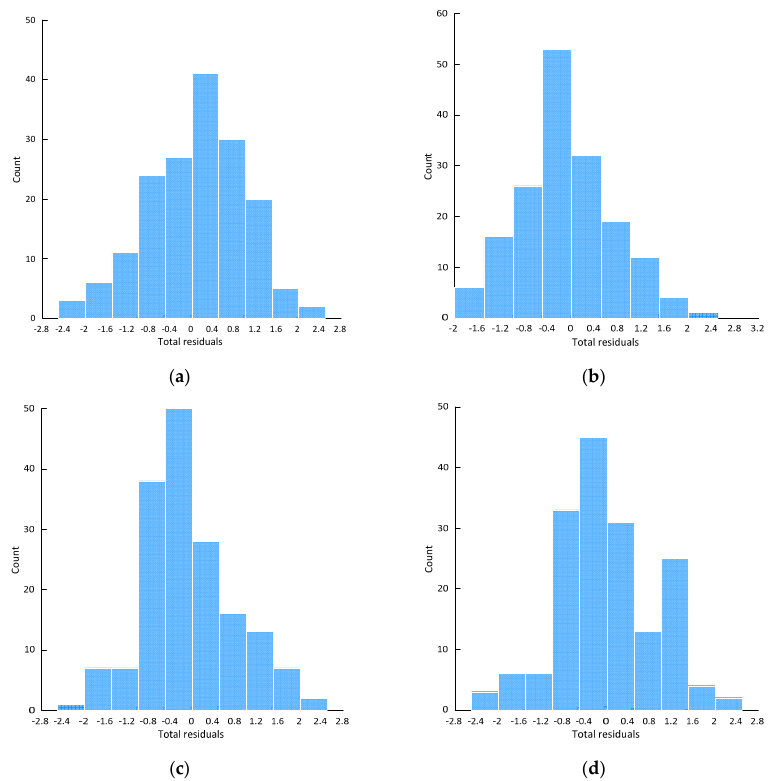
Figure 15. Distribution of normalized residuals for different periods, data set 3. ( a ) T = 0.50 s; ( b ) T = 1.00 s; ( c ) T = 1.50 s; ( d ) T = 2.00 s.